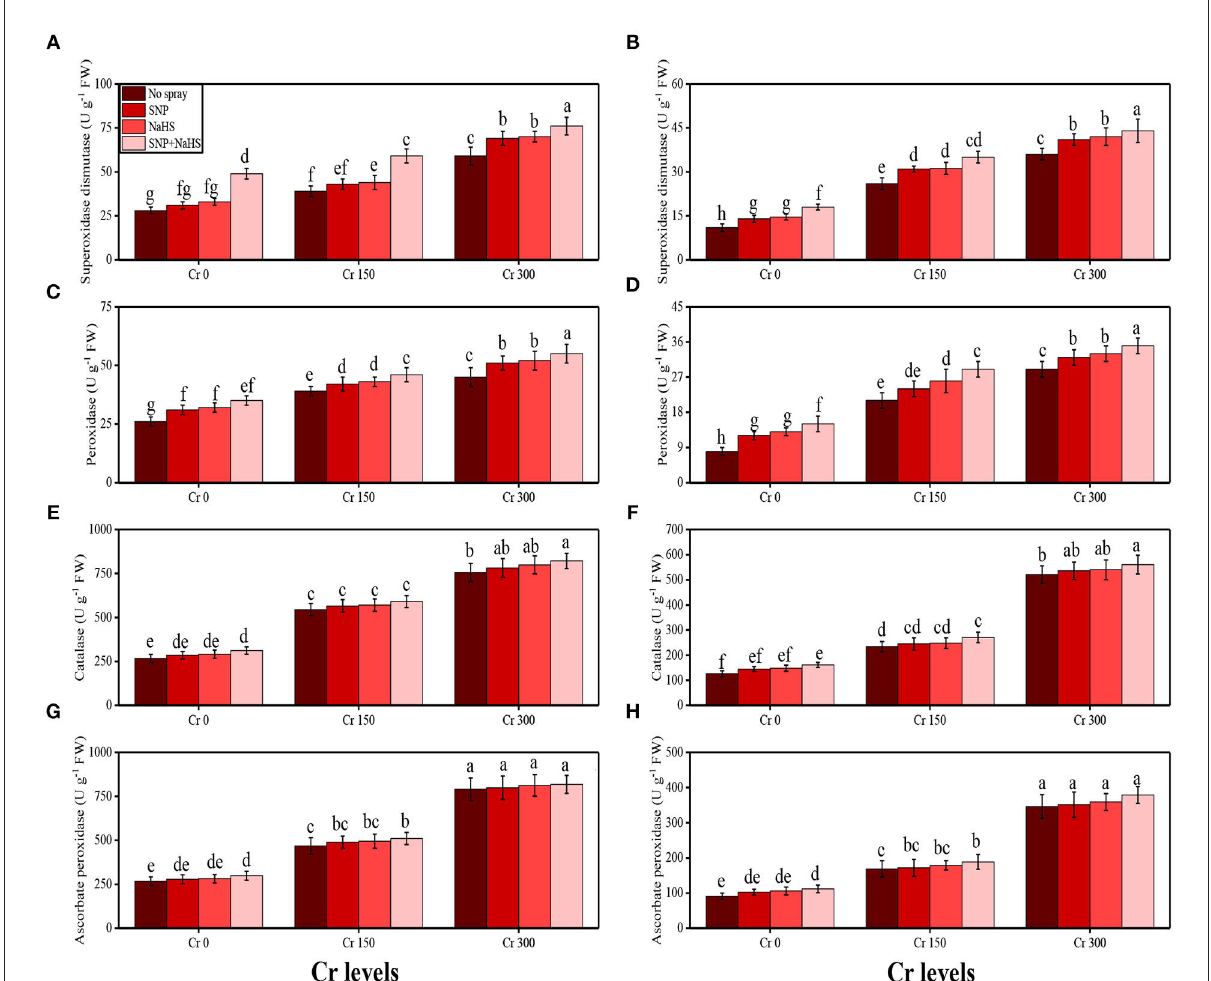
FIGURE9 Impact of individual and combinatorial application of SNP and NaHS on enzymatic antioxidative enzymes, i.e., SOD activity in the roots (A) , SOD activity in the leaves (B) , POD activity in the roots (C) , POD activity in the leaves (D) , CAT activity in the roots (E) , CAT activity in the leaves (F) , APX activity in the roots (G) , and APX activity in the leaves (H) of spinach ( S. oleracea ) plants grown under different levels of Cr [0 (no Cr), 150, and 300 µ M] in sandy loam soil. Values in the figures indicate just one harvest. Mean ± SD ( n = 4). Two-way ANOVA was performed and mean differences were tested by HSD ( P < 0.05). Different lowercase letters on the error bars indicate significant differences between the